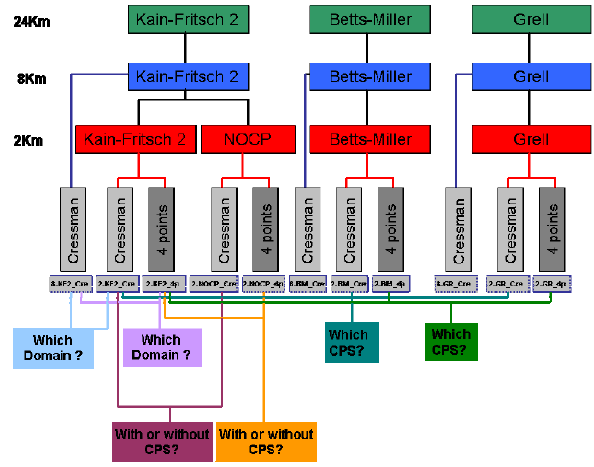
Table 1. Mean Absolute Error (MAE) (mm) for: (a) 8km grid using the Cressman method (8 KF2-Cre), (b) 2km grid using the Cress-